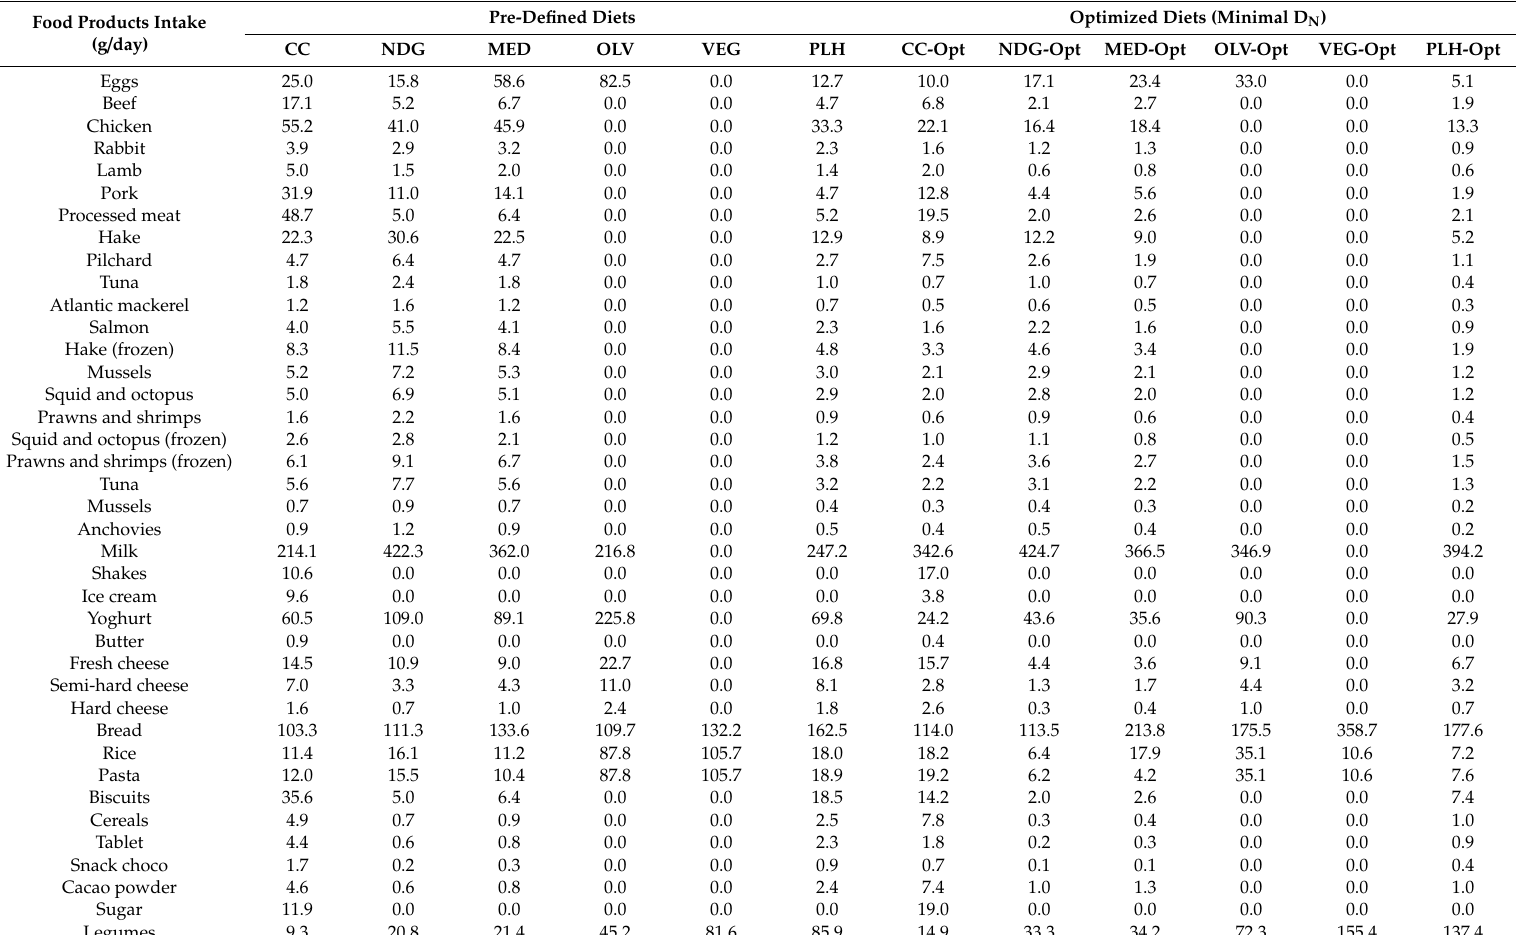
Table A4. Food intake (g / day) of all pre-defined and optimized